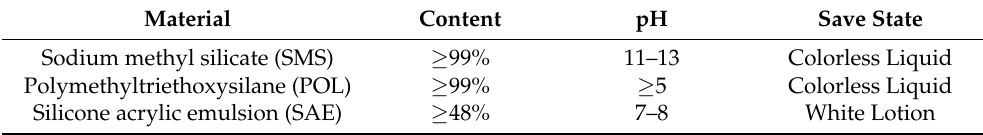
Table 2. Specific properties of silicone